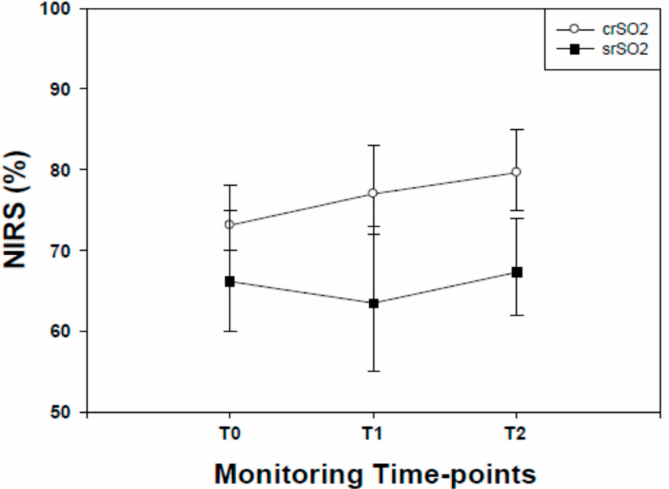
Figure 2. Cerebral (c) and splanchnic (s) regional oximetry (rSO 2 ) values recorded in late preterm infants before (T0) during (T1) and after (T2) osteopathic manipulation treatment. Data are given as median and 25–75 ◦ centiles. crSo2 values at T0 were significantly ( P < 0.001, for both) lower than those recorded at T1 and T2. srSO2 values at T0 were significantly ( P < 0.001, for both) higher than those recorded at T1 whilst no di ff erences ( P < 0.05) were found between T0 and T2. srSo2 values at T1 were significantly ( P < 0.001) lower than